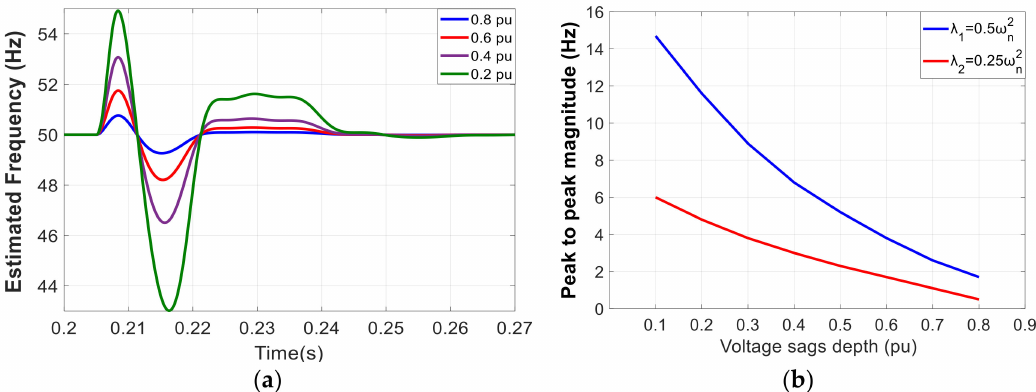
Figure 4. ( a ) Estimated frequency perturbations in the SOGI-FLL for different voltage sag depths ranging from 0.8 pu to 0.2 pu and FLL gain λ 1 = 0.5 ω 2 n . ( b ) Measured peak-to-peak maximum amplitude distortion in Hz, in blue for λ 1 = 0.5 ω 2 n , in red for λ 2 = 0.25 ω 2 n